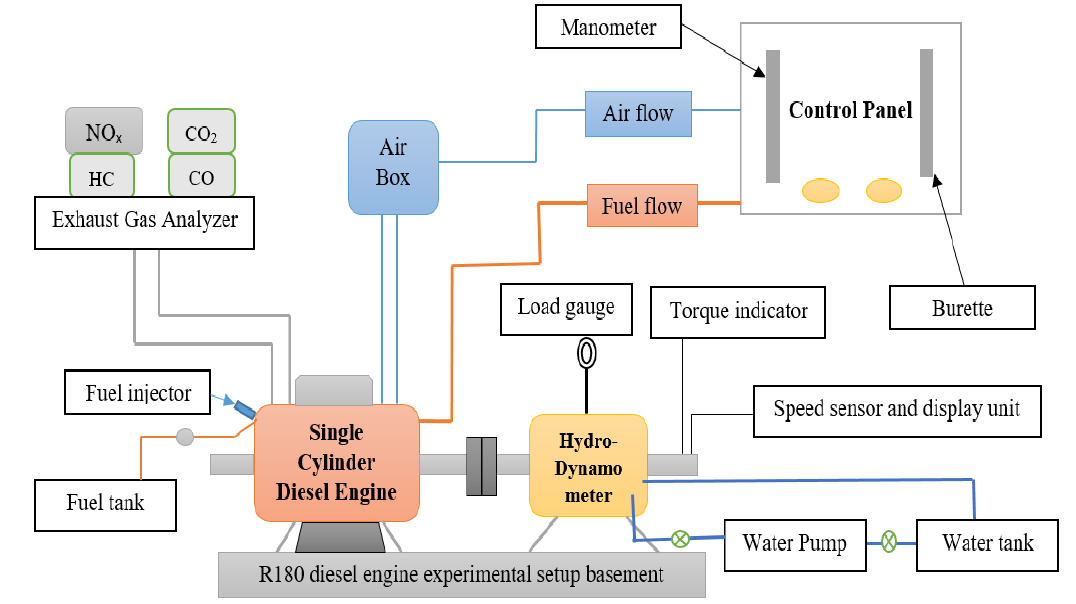
Figure 7. A diagram of the experimental setup. Table 3. The test engine’s technical specifications.